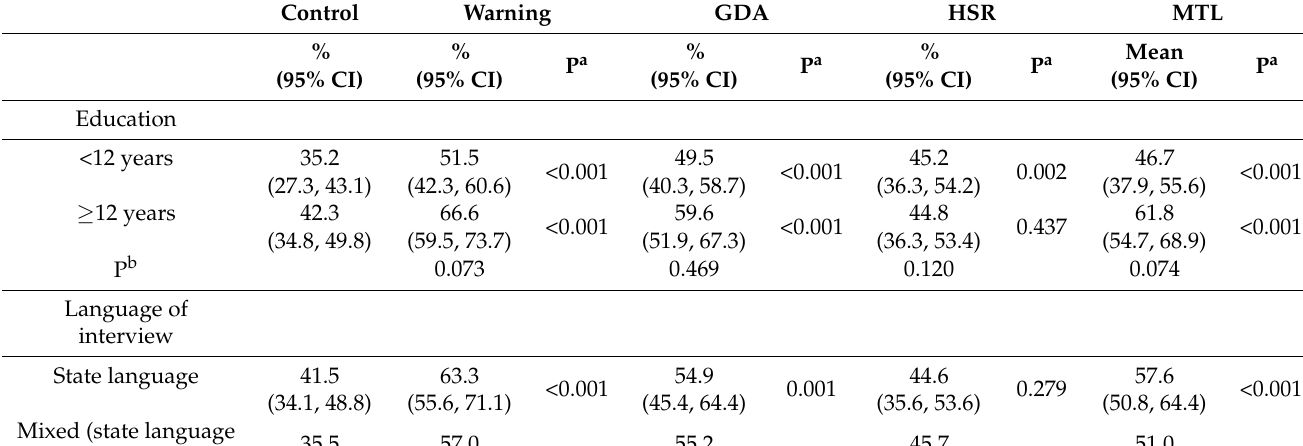
Table 3. Effect of FOPL type on the percent of participants who correctly identified products high in nutrients of concern, moderated by socio-demographic